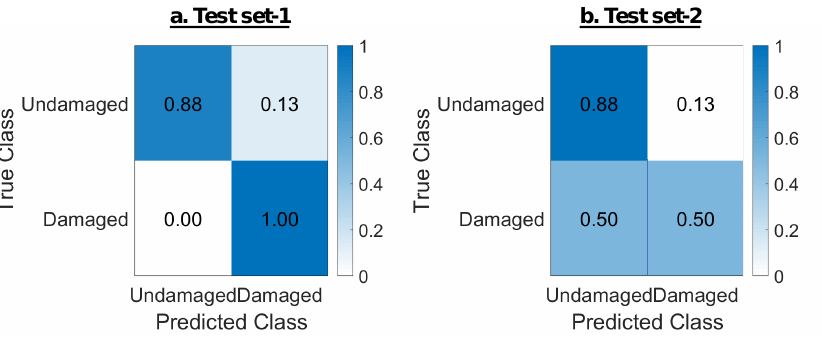
Figure 9. Confusion matrices for two test sets of TFB building to evaluate ( a ) OLR X and ( b ) OLR Y